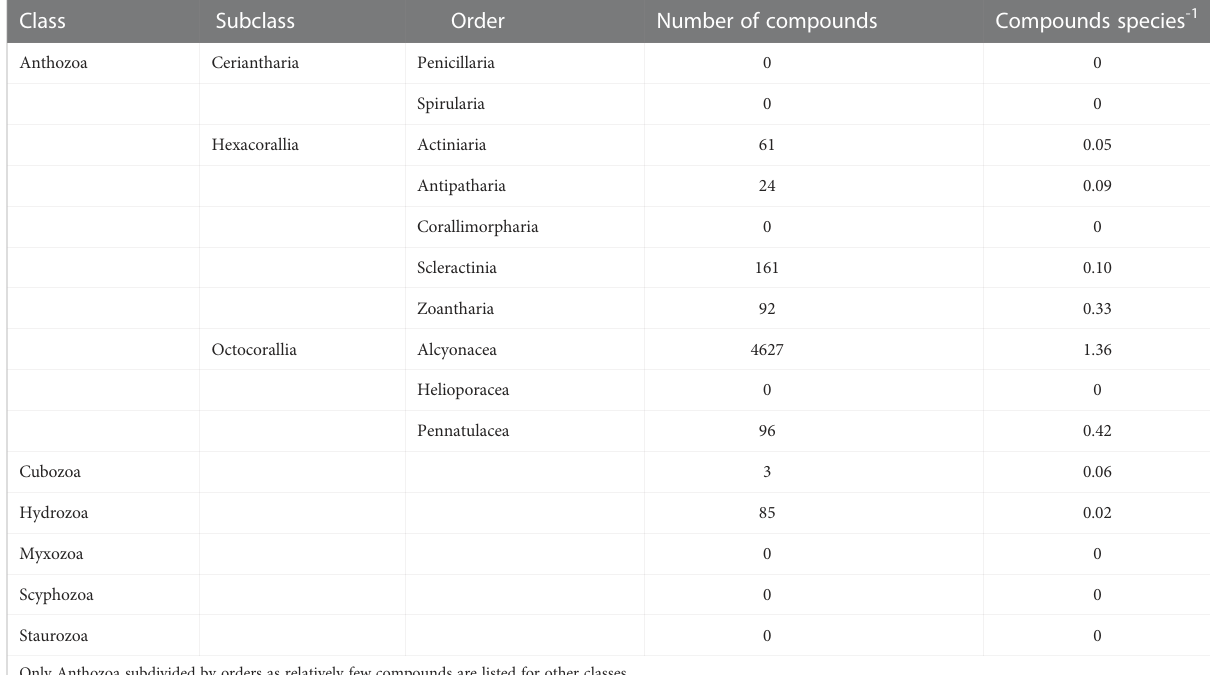
Only Anthozoa subdivided by orders as relatively few compounds are listed for other